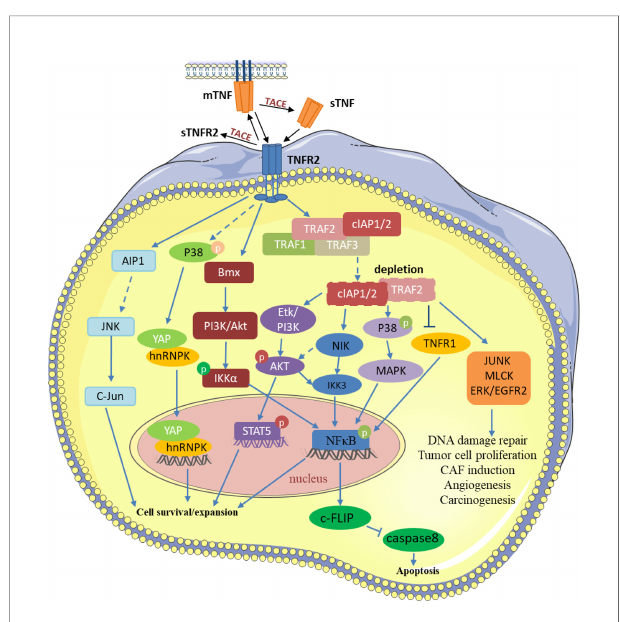
FIGURE 1 | TNF/TNFR2 participates in various processes of tumor development by regulating different signaling pathways in the tumor and tumor microenvironment. TRAF2 and TRAF2-related proteins, such as TRAF1 and cIAP1/2, are recruited to activate TNFR2. Then, TNFR2 activates NF- k B, STAT5, YAP, and other transcription factors through different pathways to induce the transcription of its target genes, thereby inhibiting tumor cell apoptosis and promoting the development of tumor cells. TNFR2 also participates in various changes in the tumor microenvironment through signal transduction such as JUNK, MLCK, and EGFR2. P,